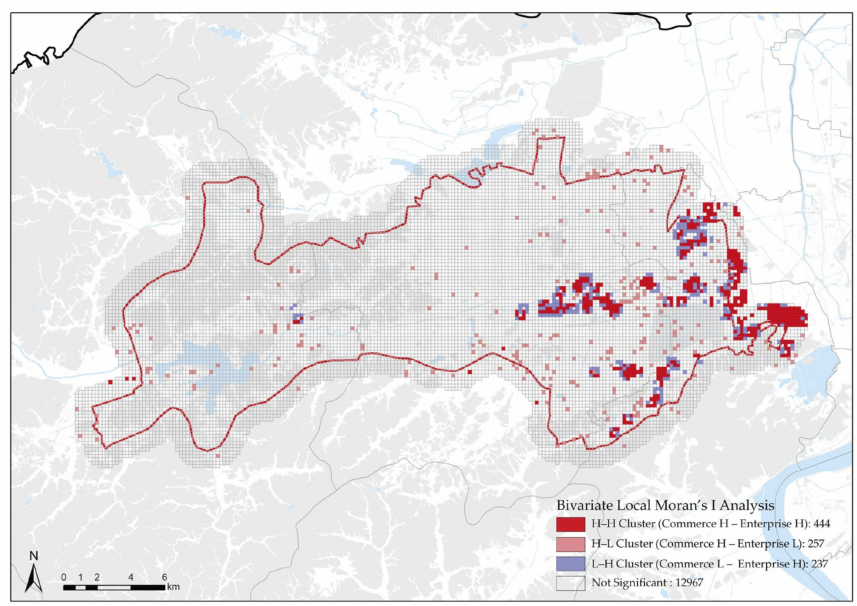
Figure 9. Bivariate local Moran’s I map between UCNs and STEs.